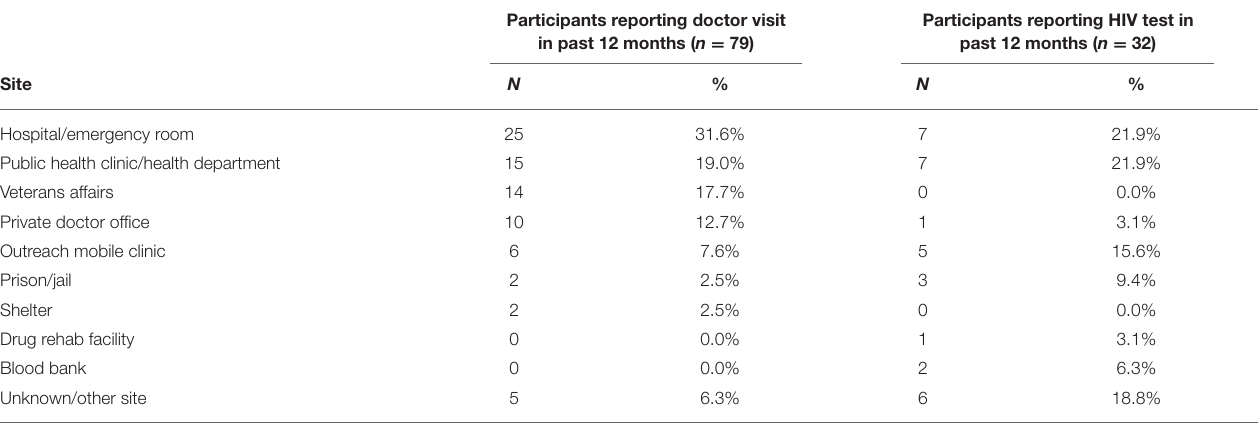
TABLE 2 | Site of last doctor visit and Last HIV test within 12 months prior to